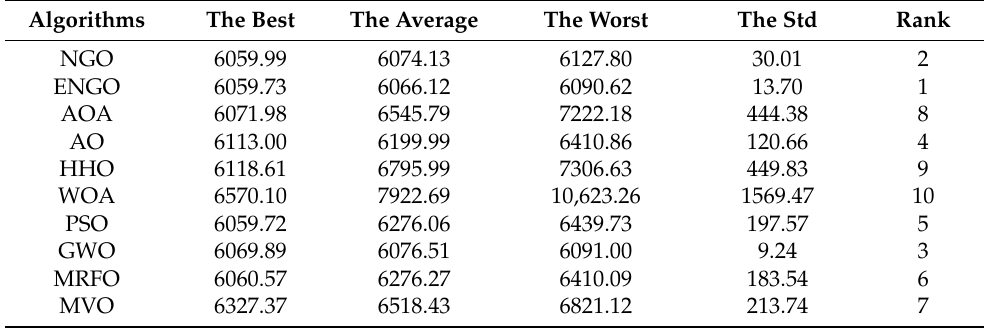
Table 4. Results of the different algorithms in solving the gear train design problem. Algorithms